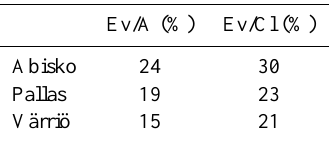
Table 1. Fraction of NPF event days compared to all analyzed days with data (Ev/A) or to days which are classified either to event or non-event days (Ev/Cl). Data from Abisko was from campaigns (most data from the winters 2005–2006 and 2006–2007 are miss- ing), and it thus cannot be compared to the values for Pallas and